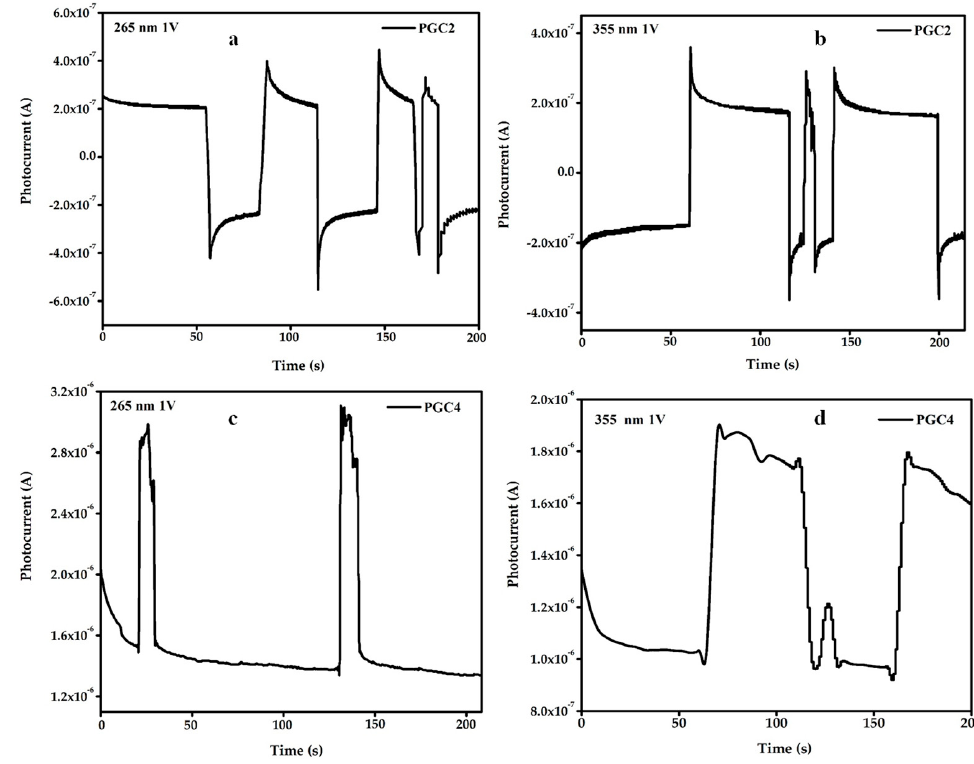
Figure 10. The time response of the PGC2 devices with the symmetric electrode, ( a ) 265 nm UV light ( b ) 355 nm UV light, and PGC4 device with ( c ) 265 nm UV light and ( d ) 355 nm UV light. Table 1. Summary of the photoresponse at 1 V for PPy-GQDs composite devices with varying thickness. Device